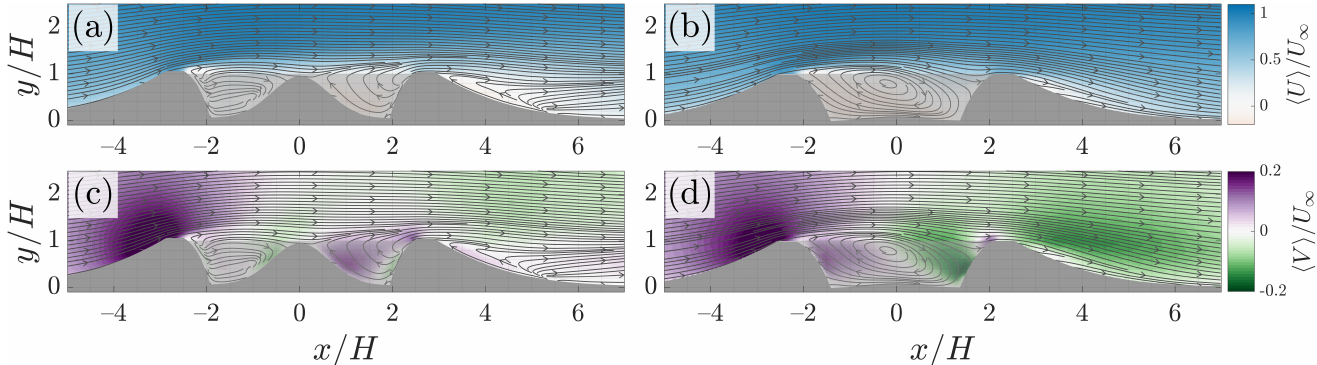
Figure 9. Contours of in-plane mean: ( a , b ) streamwise, (cid:104) U (cid:105) , and ( c , d ) wall-normal, (cid:104) V (cid:105) , velocity normalized by free- stream velocity U ∞ in the ( a , c ) centerline, z / H = 0, and ( b , d ) offset, z / H = 1.3, planes. Mean streamlines are overlaid. Re H = 8.9 × 10 3